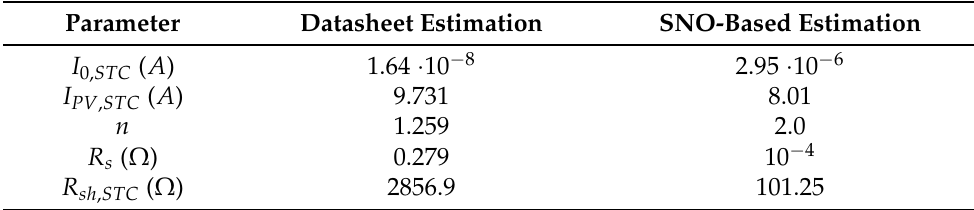
Table 2. PV module’s electrical data. SNO: Social Network Optimization.